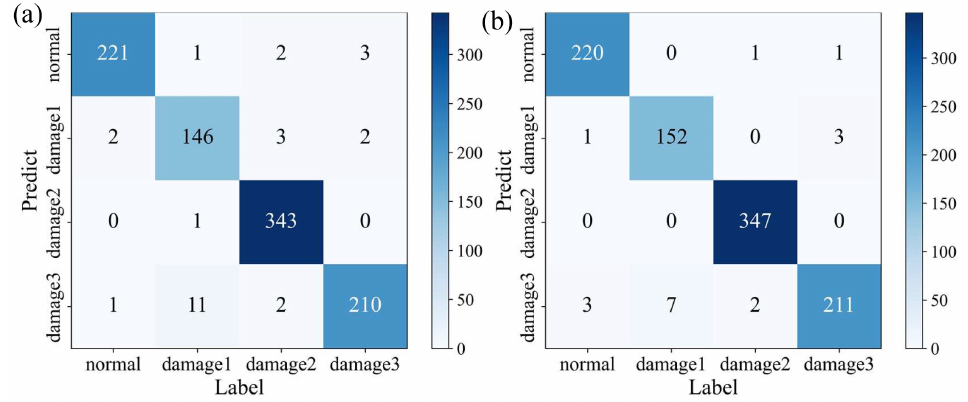
Figure 7. Confusion matrix of WTBMobileNet: ( a ) without data augmentation; ( b ) with data augmentation.